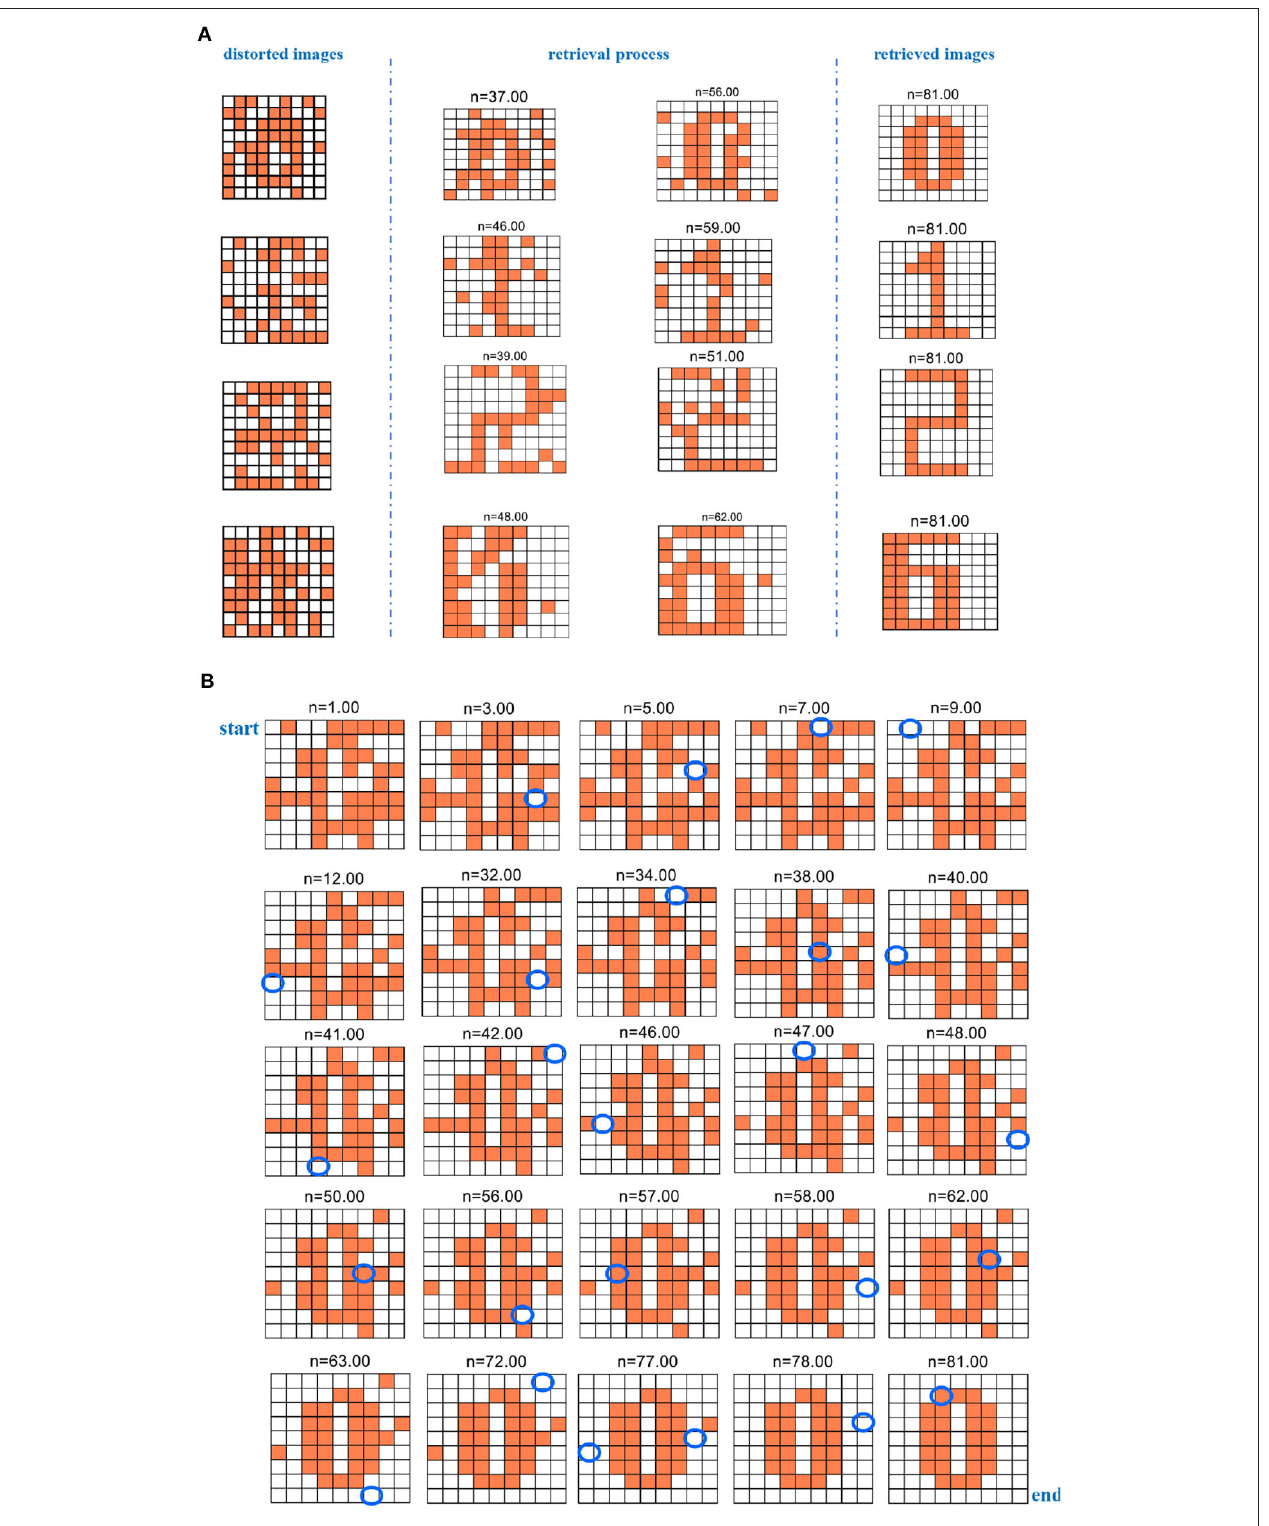
FIGURE 12 | The evolution of the retrieval process for the distorted image ( n denotes the iteration time). (A) The evolution of the retrieval process for the four distorted digit images. (B) The evolution of the retrieval process for the digit “0” distorted image.